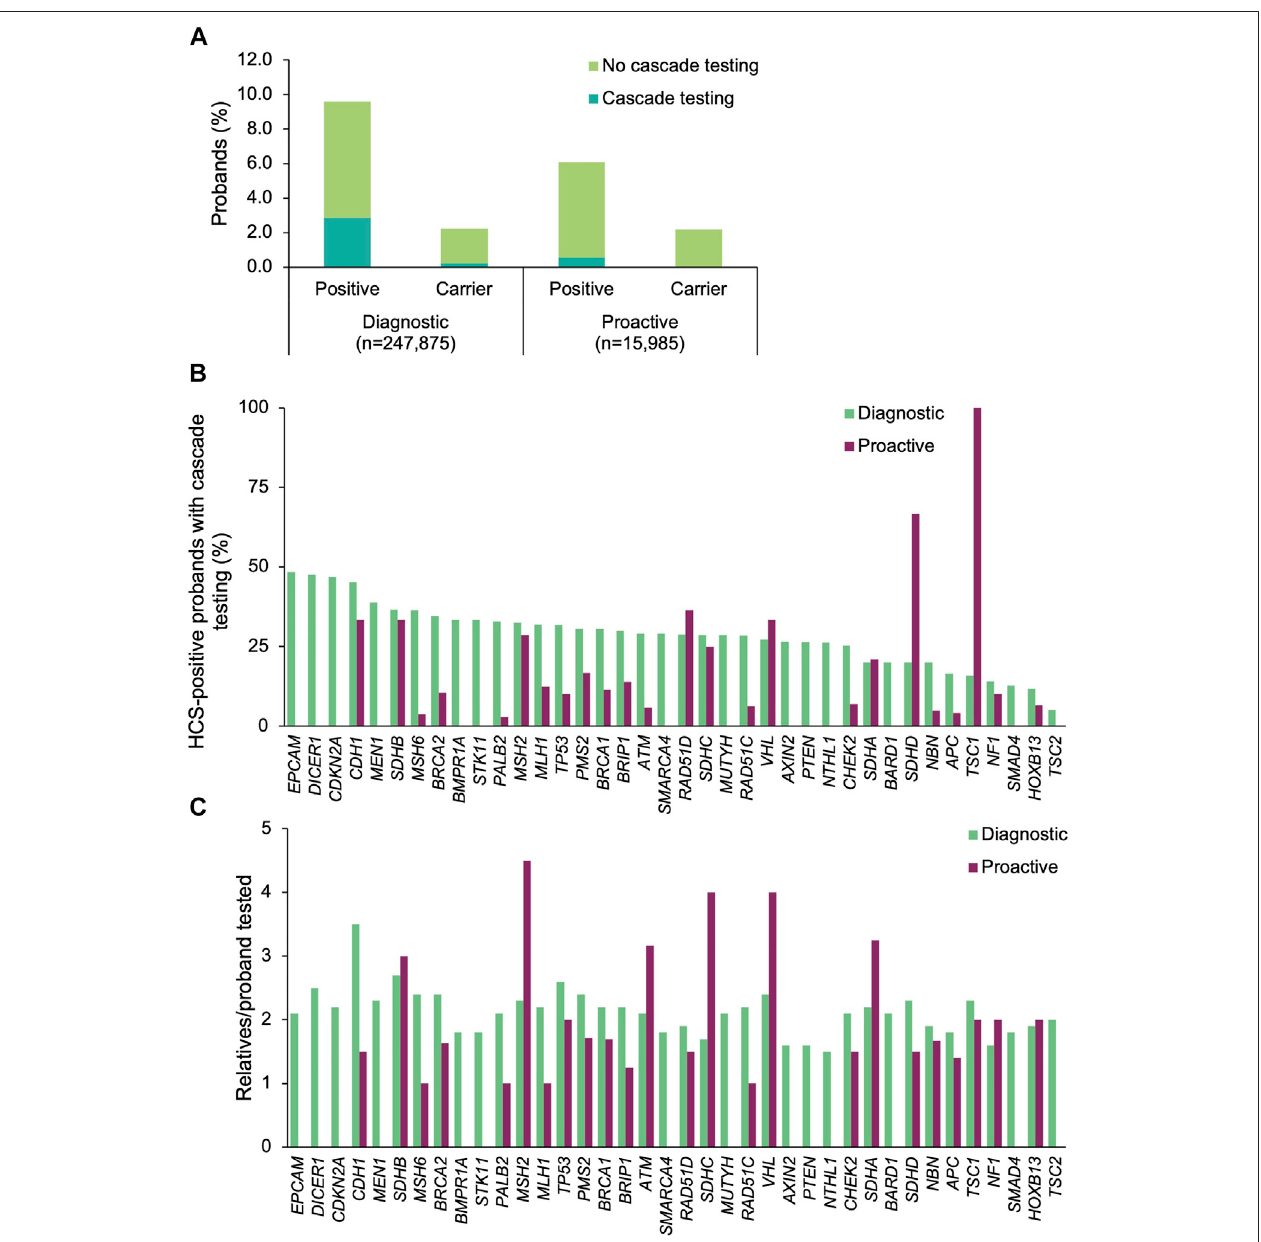
FIGURE2| Yieldofmedicallyactionable(positive)andclinicallysigni fi cant(carrier) fi ndingsinprobandswhounderwentdiagnostictestingorproactivescreeningfor HCSgenesandratesofcascadetesting. (A) ProportionofdiagnosticandproactiveprobandswithapositiveresultinanHCSgene,strati fi edbywhethercascadetesting was pursued. The denominator was the total number of probands who underwent diagnostic testing ( n = 247,875) or proactive screening ( n = 15,985) for HCS genes. (B) Proportion of probands with a medically actionable result in each HCS gene common to both diagnostic and proactive panels of interest who had at least one relativeundergocascadetesting.ThedenominatorwasthenumberofprobandswithapositiveresultineachHCSgeneforeachcohort.Probandswithapositive fi nding in morethan oneHCS genewereincluded incalculationsfor each gene.Thirty-eight ofthe45shared HCS genesareshown. Datafor theremaining sevengenescanbe found in Supplementary Table S3 . (C) Mean number of relatives who pursued cascade testing per proband with a positive result in an HCS gene. If cascade testing was pursued for positive fi ndings in more than one gene detected in the proband, the relatives and probands were included in the calculations for each gene. Data are shown for 38 genes; data for the remaining seven genes can be found in Supplementary Table S3 . HCS, hereditary cancer syndrome.